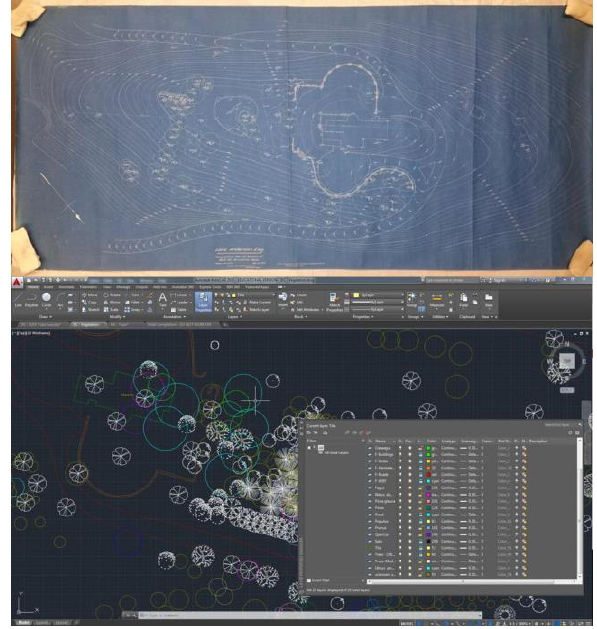
Figure 5. CAD drawing of Anderson site from historic site